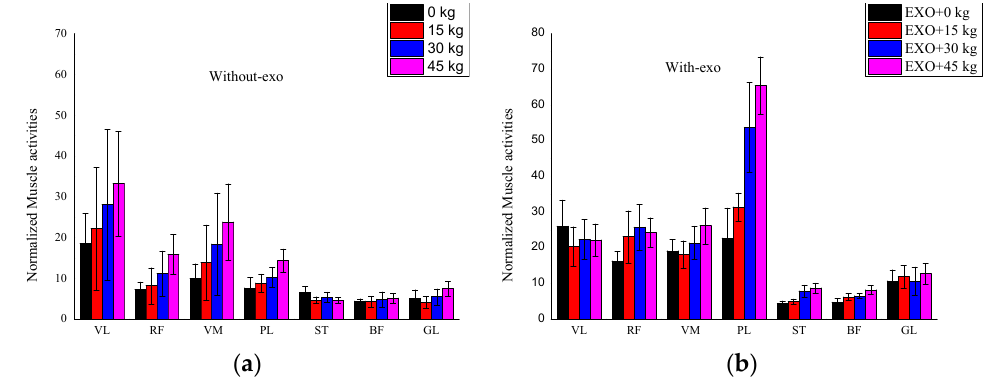
Figure 8. Normalized averaged muscle activities of with-Exo and without-Exo load carriage walking.